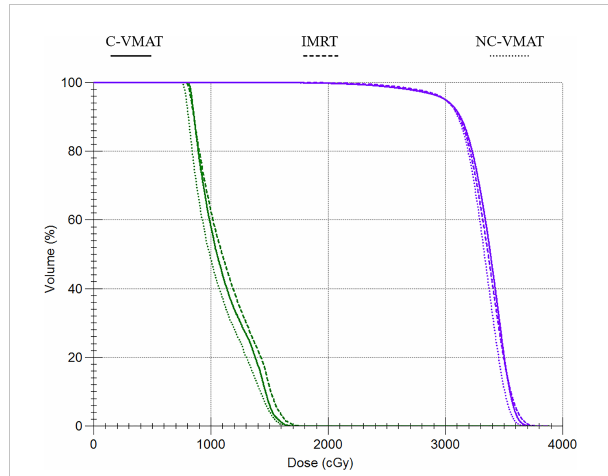
FIGURE 2 Dose-volume histograms (DVHs) comparison for WB-PTV and OARs between IMRT, C-VMAT and NC-VMAT plans. a. The purple line represents the WB-PTV b. Green line represents the hippocampus.